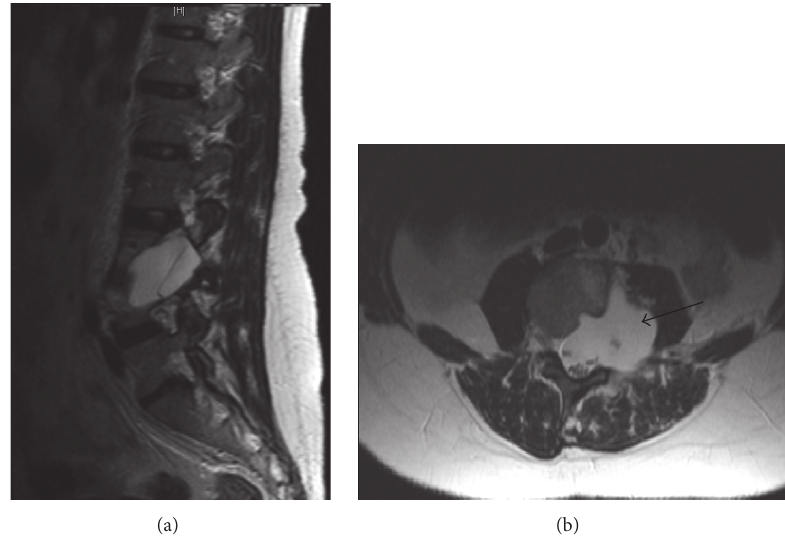
Figure 1: Preoperative MRI sagittal and axial T2-weighted postgadolinium images showed a pseudomeningocele at L3-L4 levels with paravertebral extension and psoas muscle remodeling (black arrow).